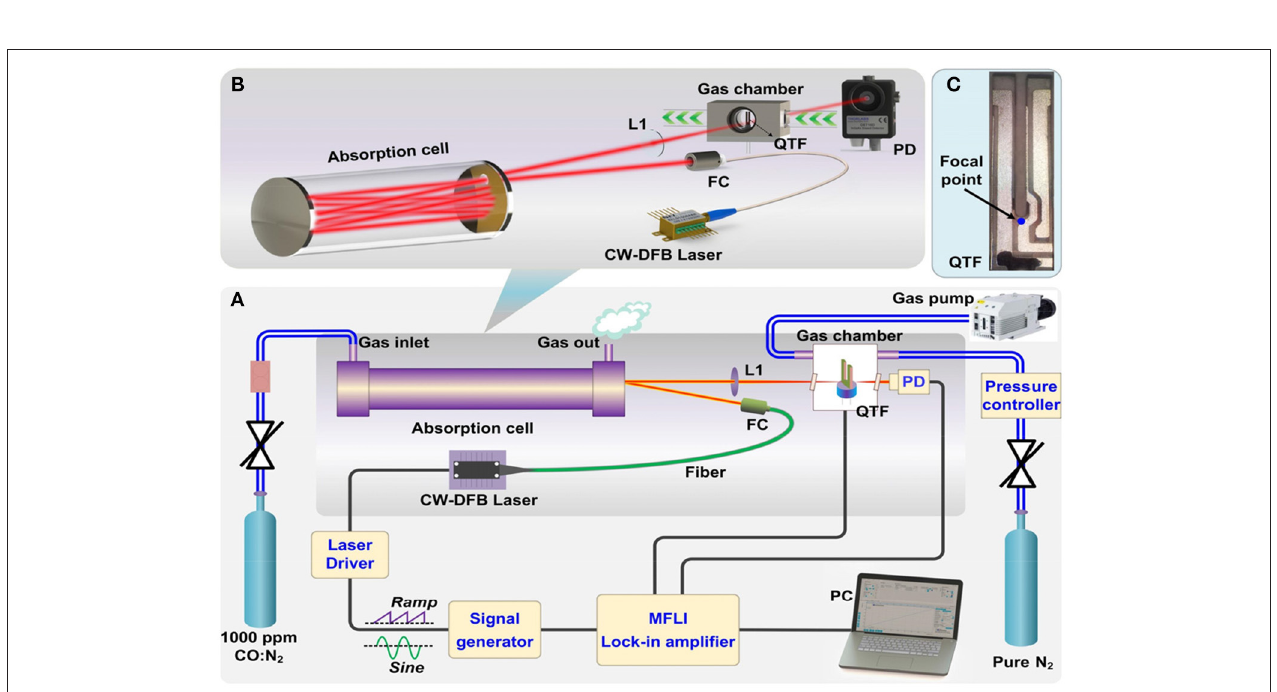
FIGURE 11 | (A) Schematic of a QEPTS sensor system. (B) The particular optical path structure. (C) The image of the used QTF. Reprinted with permission from [99] © The Optical Society.